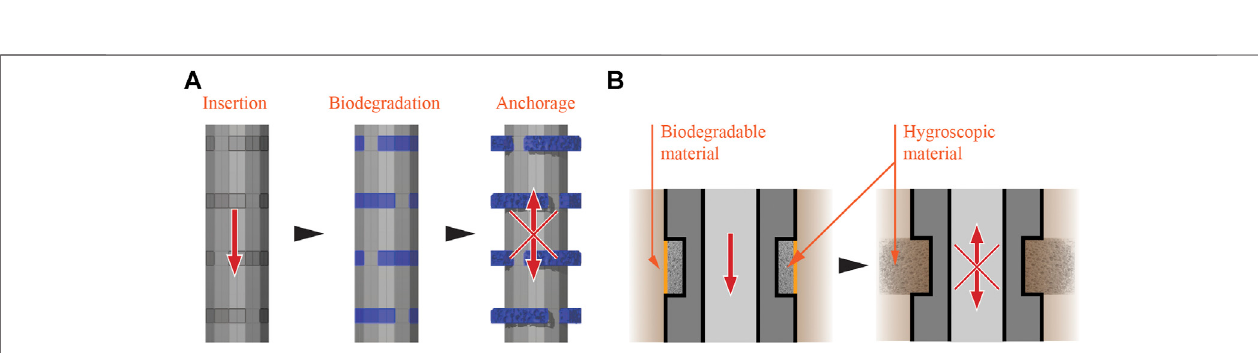
FIGURE7| Shape-changefoundationbasedonhygroscopicmaterials — Thesmoothfoundationpileisdrivenintothesoil (A-left) ,thenthebiodegradablematerial decays (A-middle) . The material decomposition exposes the hygroscopic material to the saturated soil, resulting in a three-dimensional structure and increased anchorage through friction (A-right), (B-left and right) show the disposition of the materials before and after the decomposition of the biodegradable material.